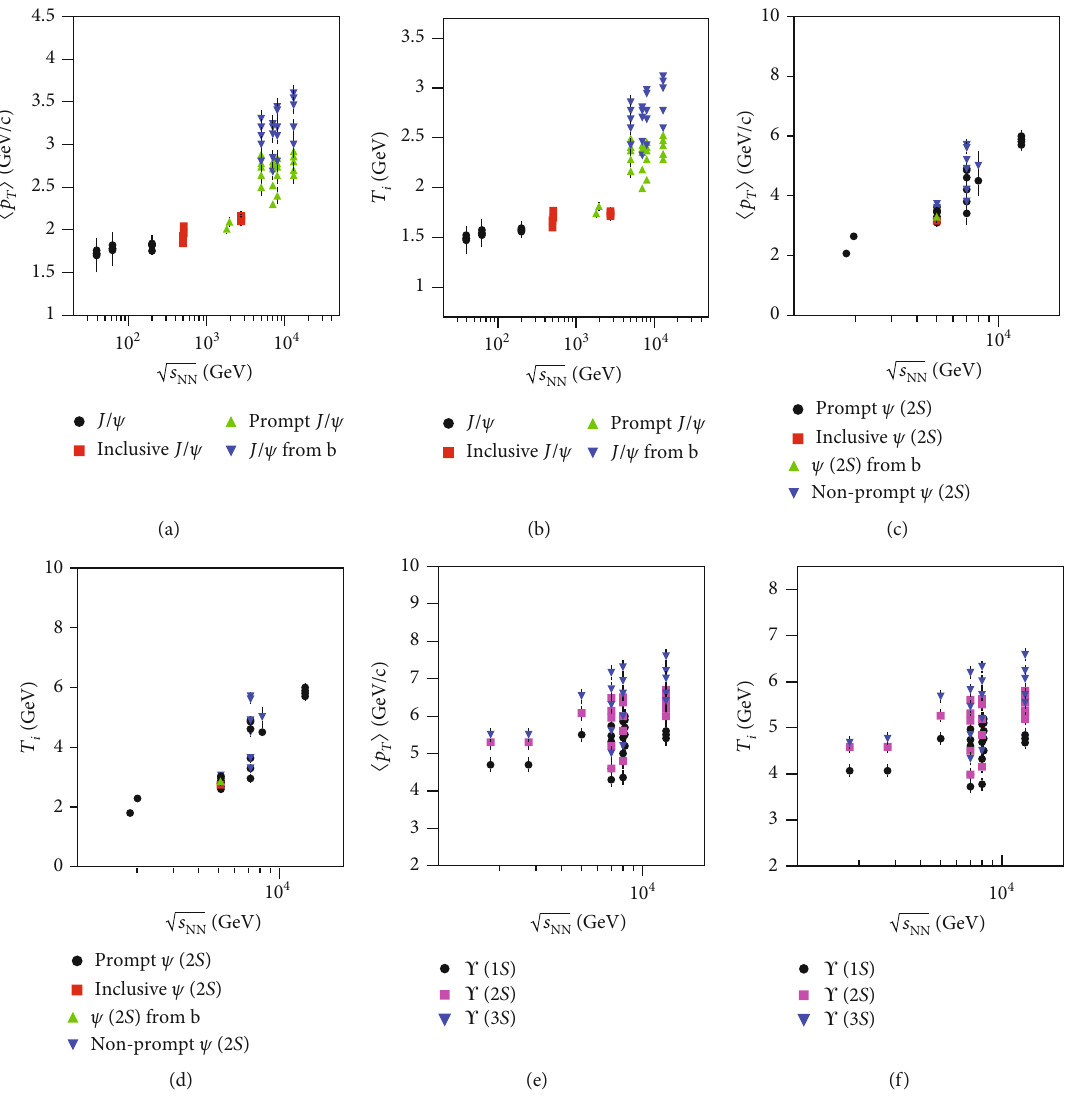
Figure 7: Dependences of (a, c, and e) h p di ff erent symbols represent the parameter values derived from Figures 1 – 6 and listed in Tables 1 and 2 where only the (two-component) Erlang distribution in the p T region of data available is used as an example. By using the mentioned three functions which fi t the data good enough in the p T region of data available, one can obtain similar h p T i (or T i ) within a systematic uncertainty of